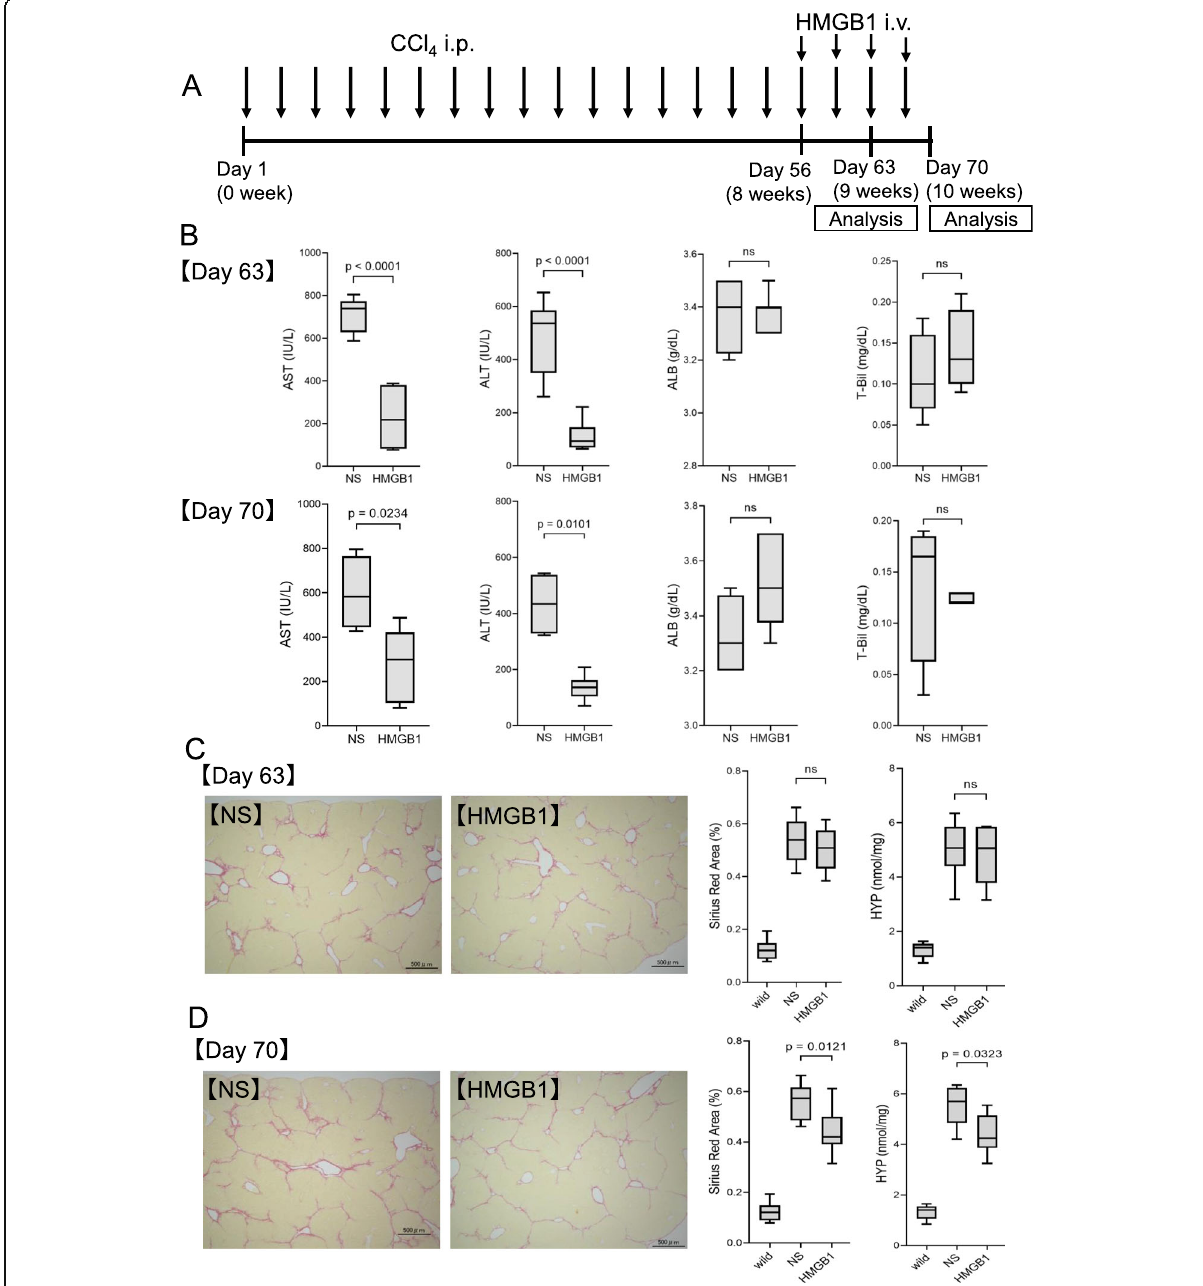
Fig. 2 Therapeutic effects of HMGB1 peptide (1 or 2 weeks of treatment) in the CCl 4 -induced mouse cirrhosis model. A Schematic of this experiment. B Serum levels of AST, ALT, ALB, and T-Bil on days 63 (1 week of treatment) and 70 (2 weeks of treatment). C Sirius Red staining and quantification of hydroxyproline levels on day 63 (1 week of treatment) and D Sirius Red staining and quantification of hydroxyproline levels on day 70 (2 weeks of treatment). NS, normal saline, n = 8 in each group. Data are presented as means ± standard deviations. ns, not